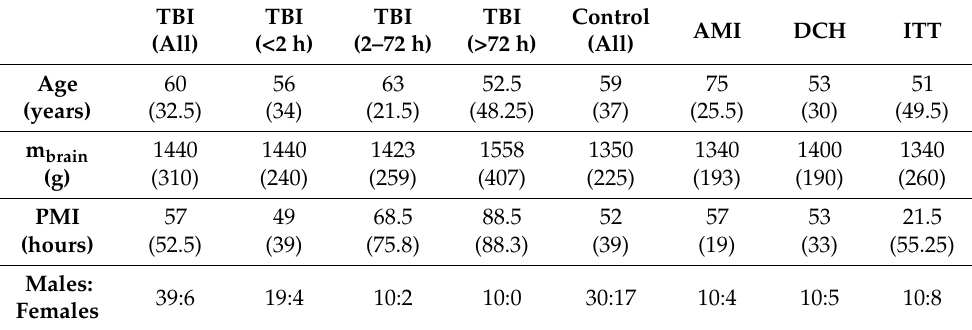
Table 1. Median age, brain weight (m brain ), postmortem interval (PMI) and sex ratio (interquartile range in parentheses) for the traumatic brain injury (TBI) and control groups and respective sub- groups. AMI, acute myocardial infarction; DCH, diffuse cerebral hypoxia; ITT, isolated torso trauma.